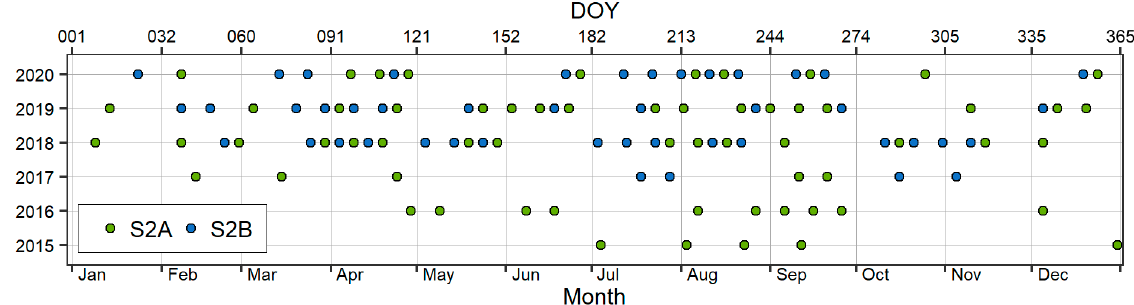
Figure 4. Overview of a total of 107 available Sentinel-2 A and B (S2A and S2B) images containing at least 20% valid surface information within the study area and their overpassing dates in day-of-year (DOY) for the observation period from June 2015 (launch of S2A) until the end of 2020.